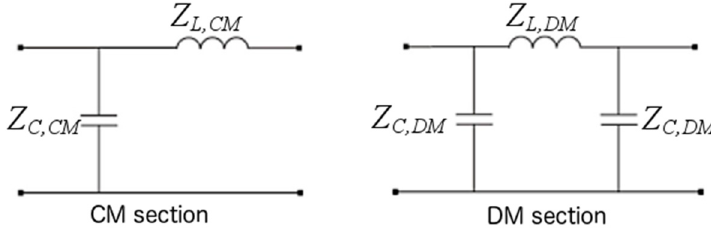
Figure 6. Schemes of the considered CM and DM EMI filter sections.